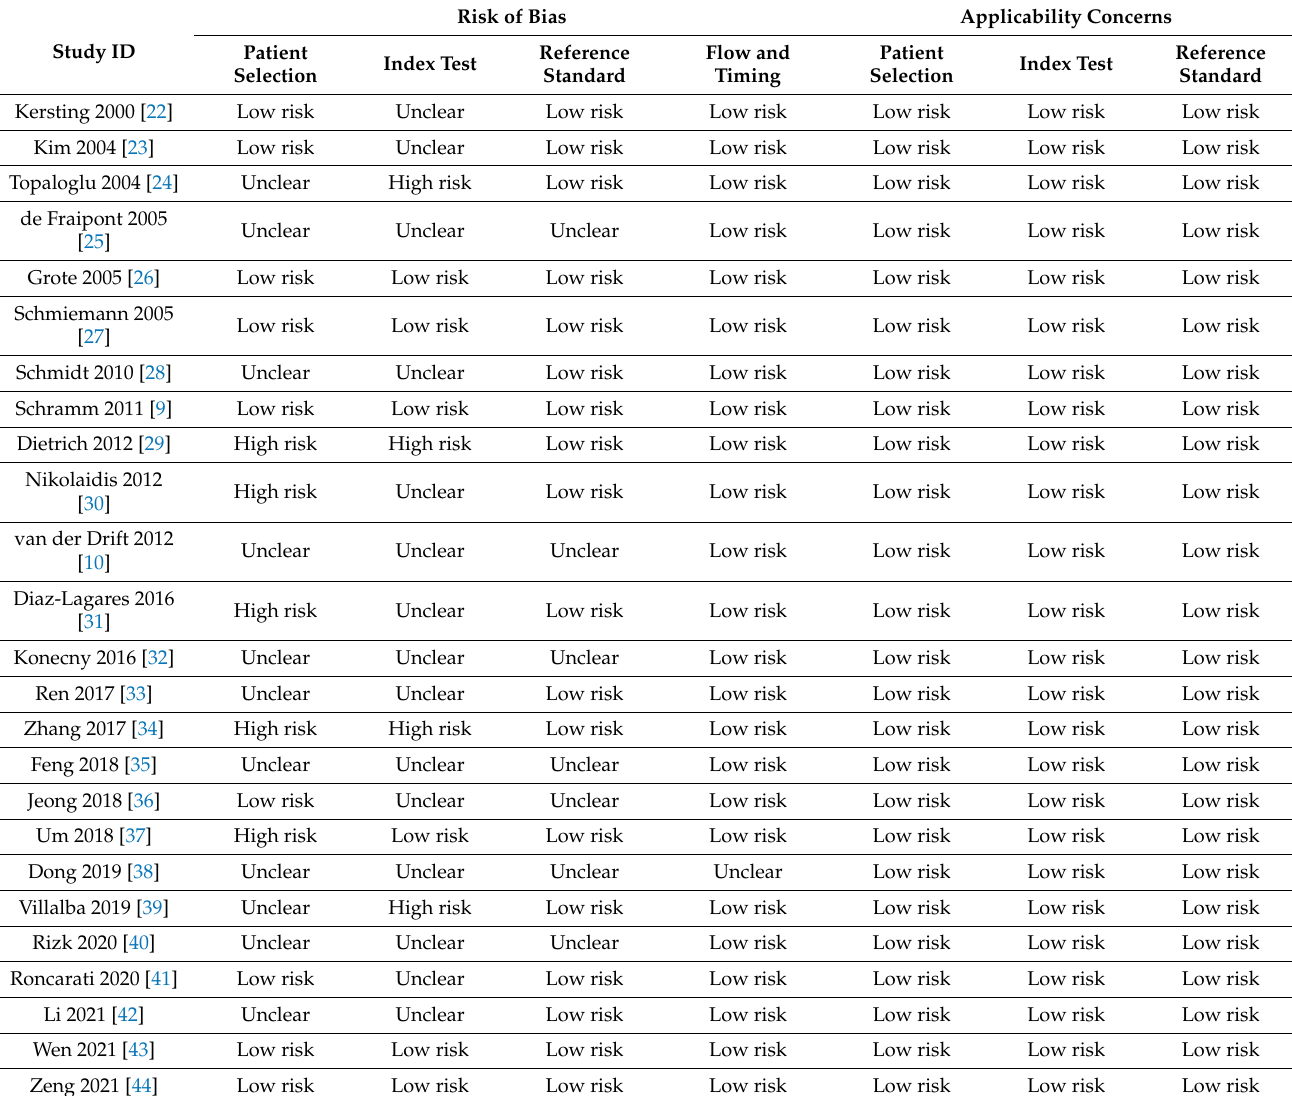
Table 3. Risk of bias assessed by the QUADAS-2